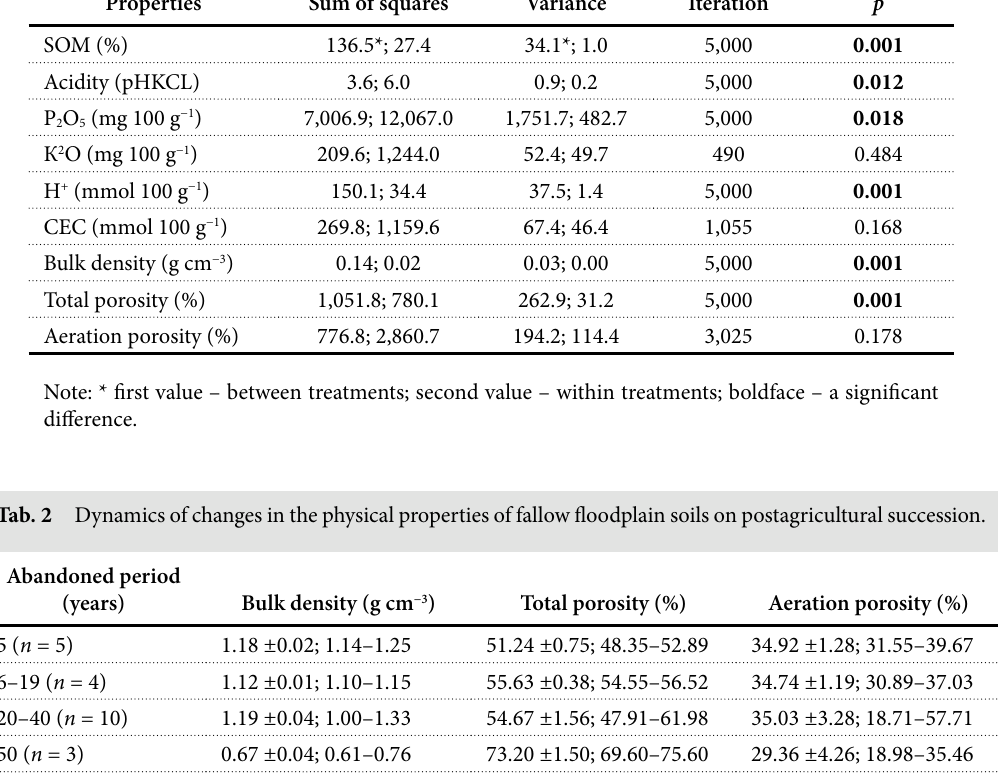
Tab. 1 Results of the permutation tests to determine the differences in soil properties in ecosystems of various duration following abandonment.